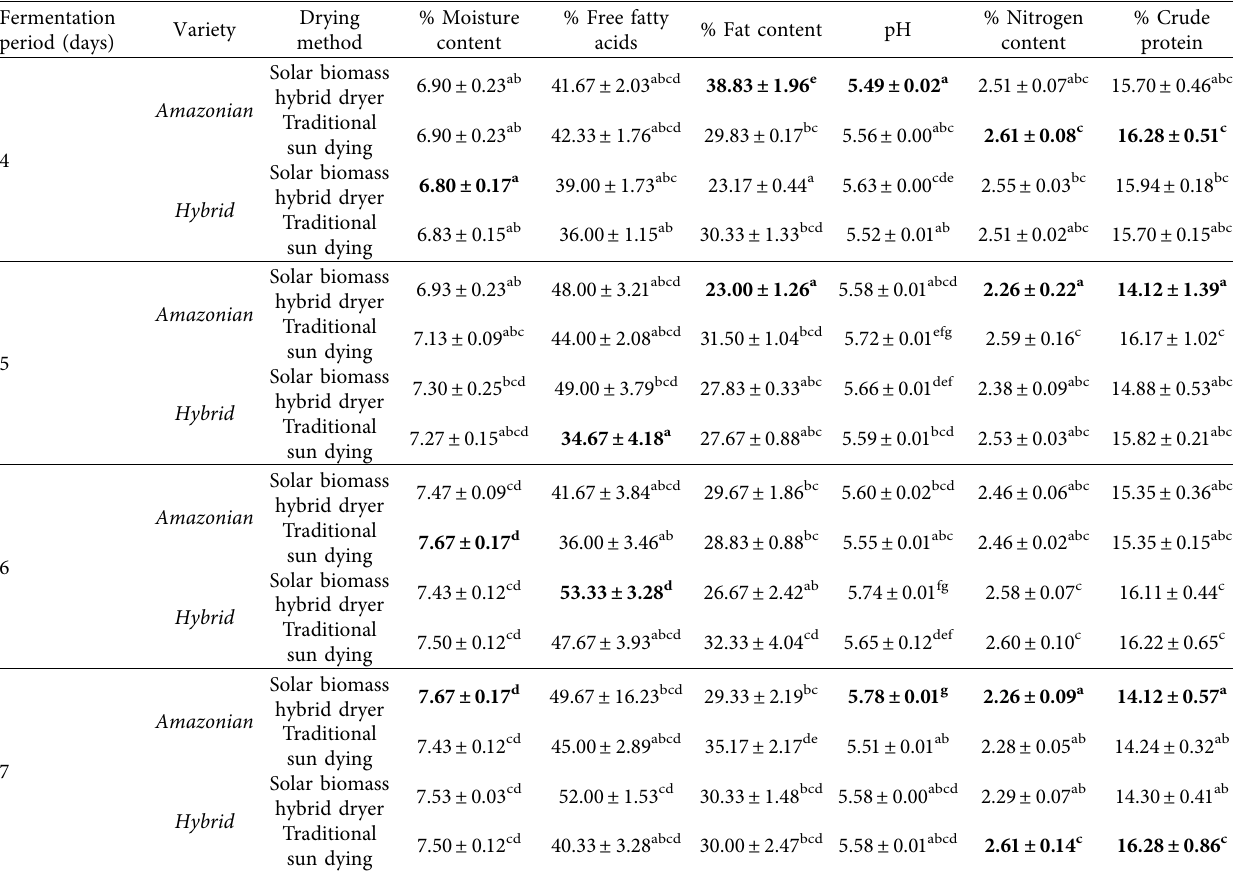
Table 1: Proximate analysis and pH of cocoa varieties under different fermentation and drying periods. Fermentation period